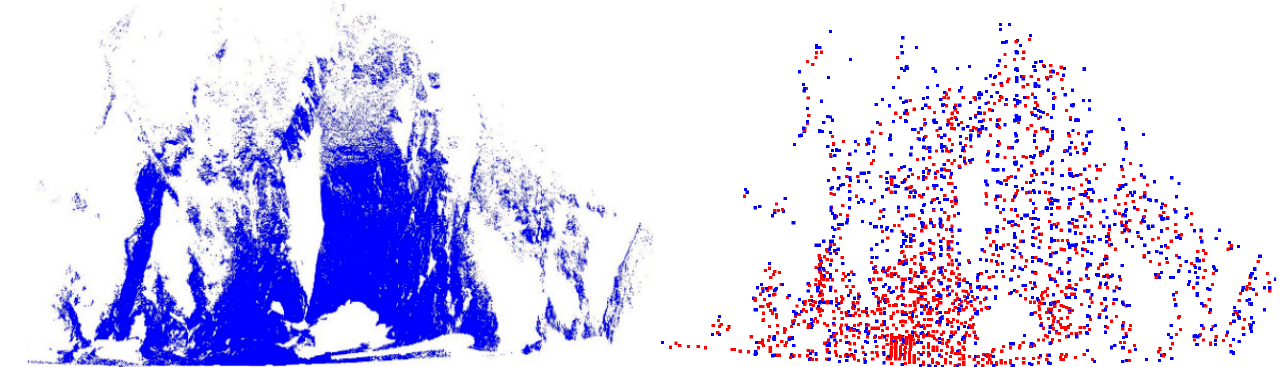
Figure 1. Key points extraction of NARF + SIFT algorithm.